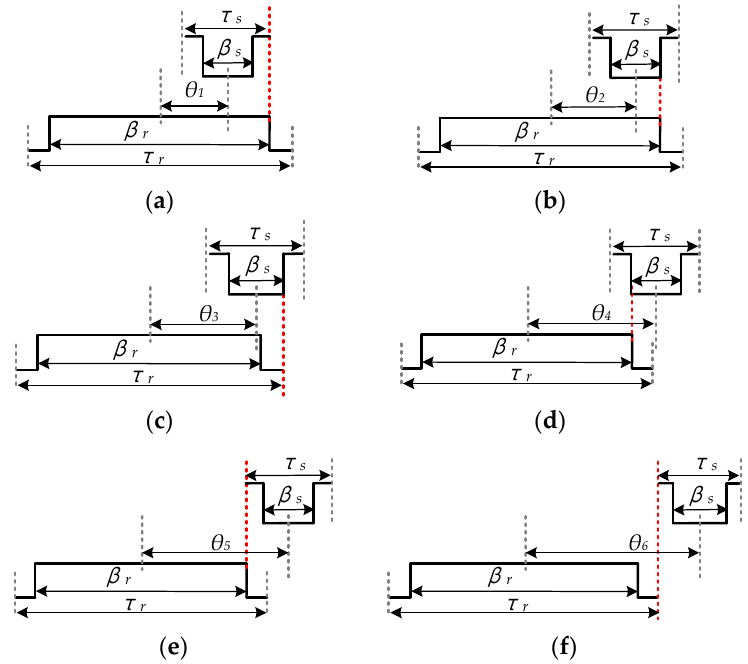
Figure 3. Rotor positions at different regions: ( a ) Region one; ( b ) Region two; ( c ) Region three; ( d ) Region four; ( e ) Region five; ( f ) Region six.